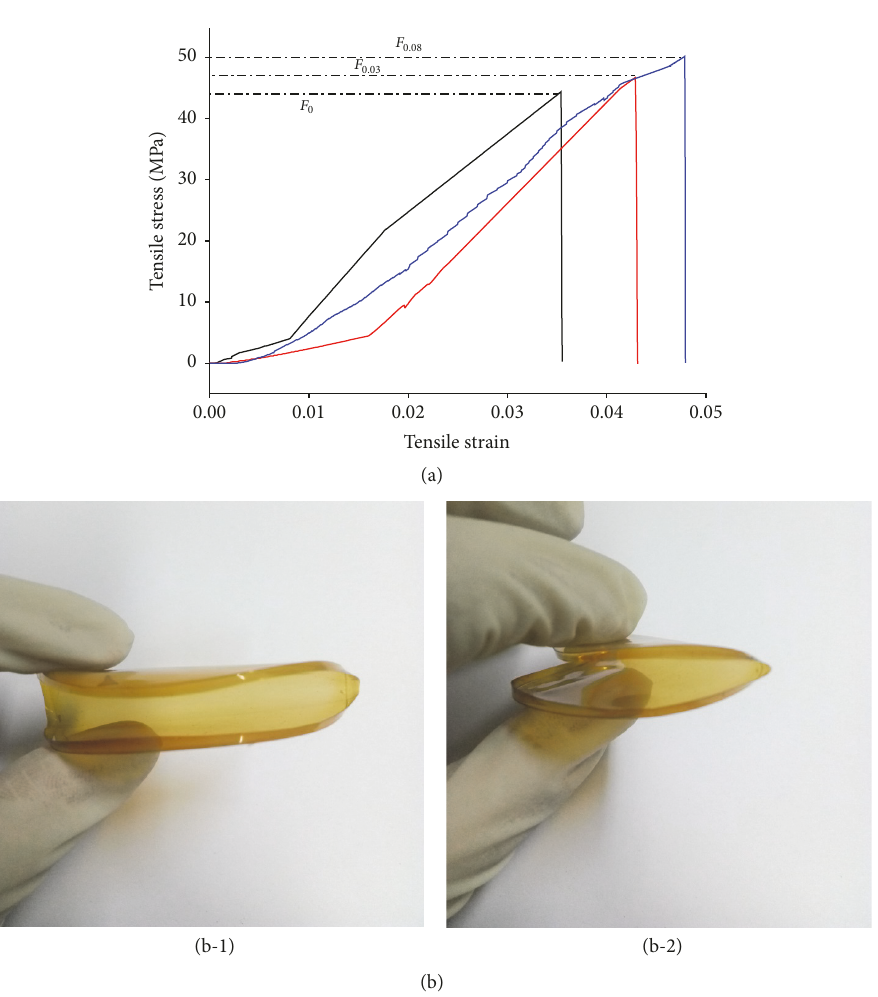
Figure 6: (a) Tensile-strain curves of composite films (F 0 , F 0.03 , and F 0.08 ). (b) Toughness tests of composite film F 0.08.